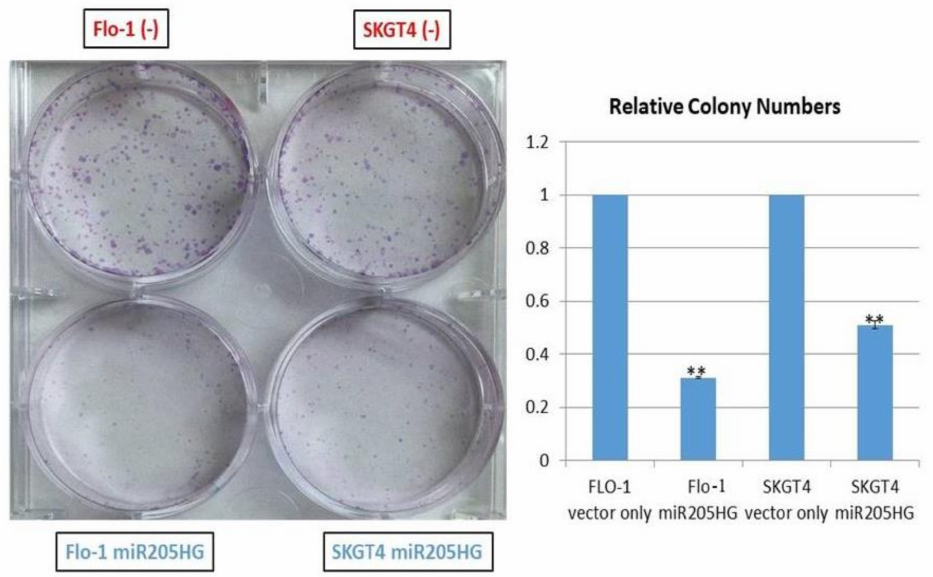
Figure 9. Substantial reduction in colony formation in EAC cells caused by miR205HG overexpression. Clonogenic assays revealed that miR205HG overexpression induced a substantial and significant reduction in colony formation in SKGT4 (49% reduction; ** p -value < 0.02) and FLO-1 (69% reduction; ** p -value < 0.01) EAC cell lines.